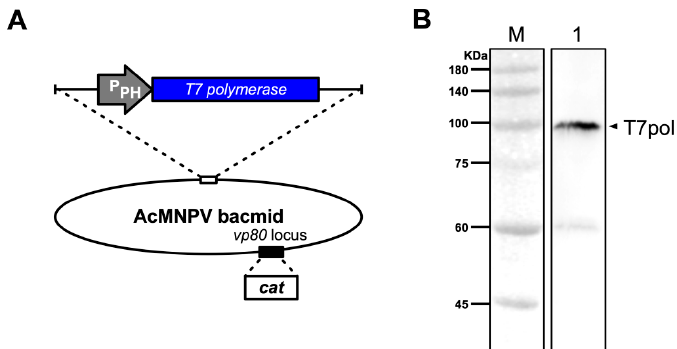
Figure 2. Construction and identification of a AcMNPV bacmid (AcBac-T7pol- Δ vp80) expressing T7